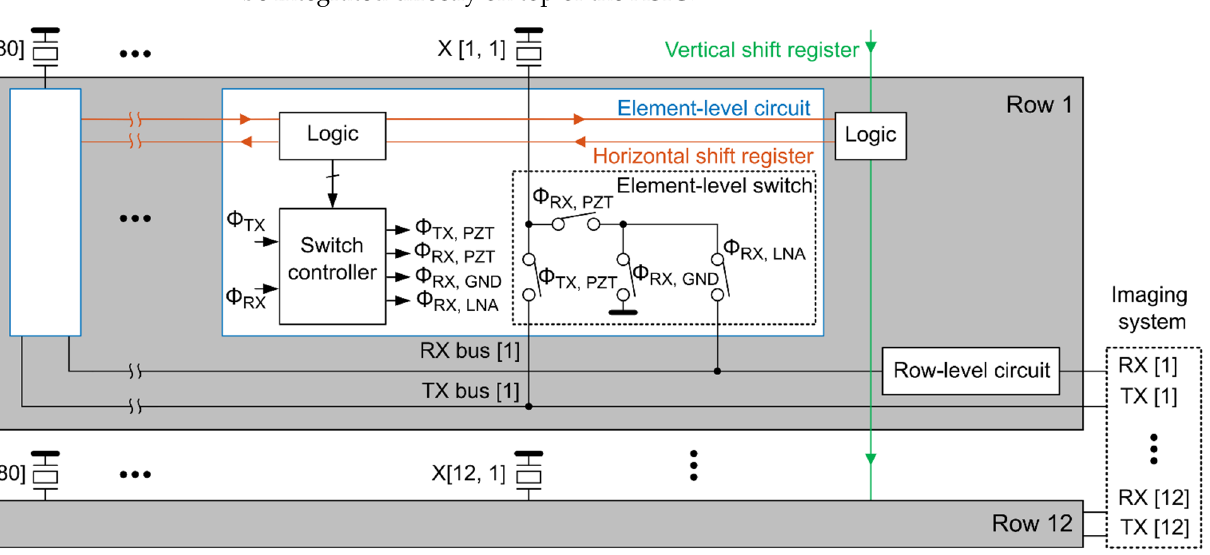
Figure 3. Block diagram of the architecture of a single ASIC.